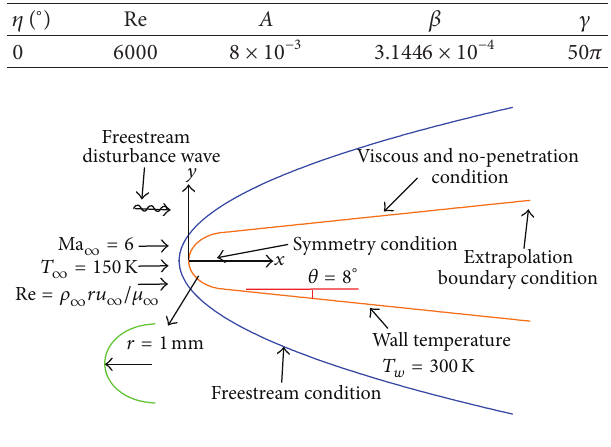
Figure 3: The pressure disturbance mode obtained under two grid